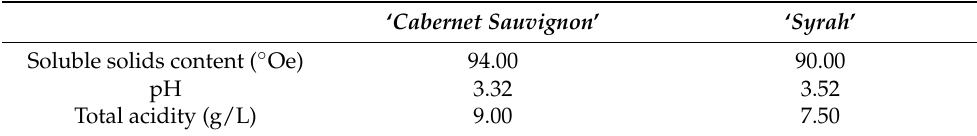
Table 1. Physicochemical parameters of musts.